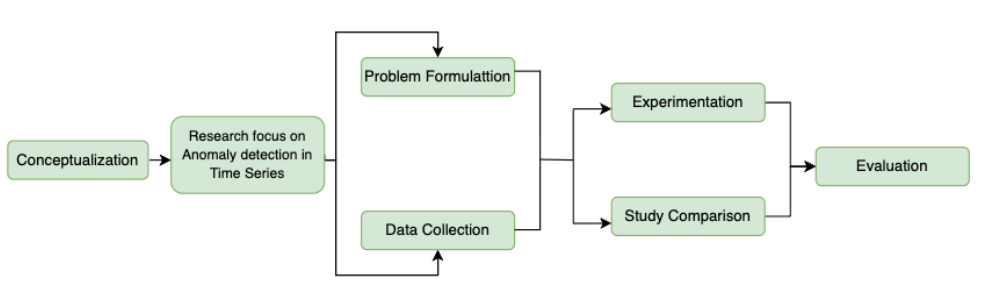
Figure 1. Research methodology